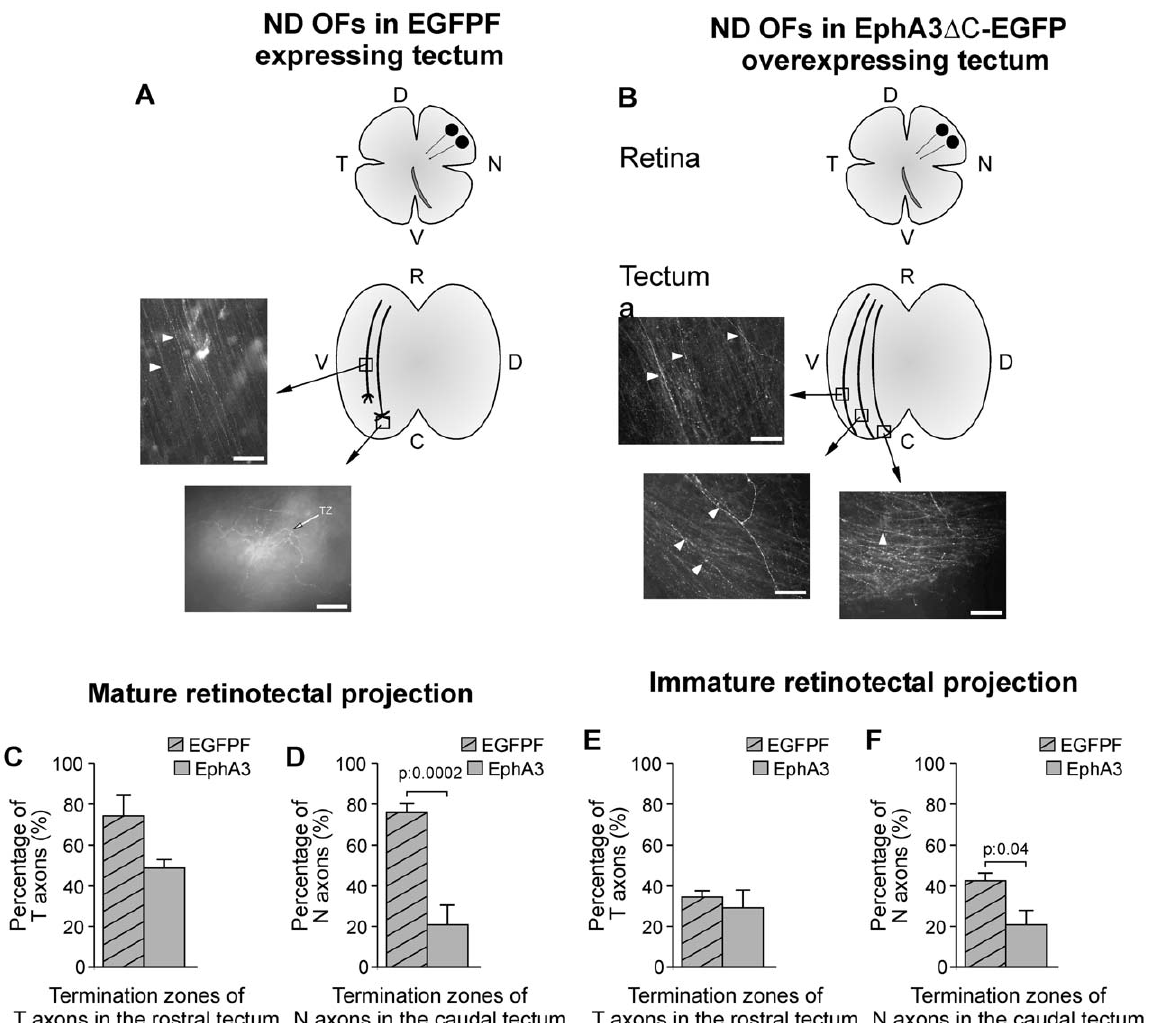
Figure 7. EphA3 ectodomain overexpression alters the topographic map formation. After infection of the optic tectum at E2 with RCAS- BP-B-EGFPF (control) (A) or with RCAS-BP-B-EphA3 D C-EGFPN3 (B) and DiI labeling of the naso-dorsal retina at E16, the retina and the tectum were analyzed in whole mounts at E18 (A, B). Graphs represent retinal whole mounts labeled in naso-dorsal areas (ND) with DiI (black circles) (upper) and tectal whole mounts where the corresponding DiI labeled RGC axons (drawings) are shown in microphotographs. (A) Optic fibers (OFs) pass throughout the intermediate tectum (arrowheads) and form a termination zone (TZ) (arrow) over an area of EGFPF expression in the corresponding target area (caudal tectum) in a control tectum. (B) OFs pass through the target area (caudal tectum) without producing TZs (arrowheads) in a tectum where EphA3 D C-EGFP was overexpressed. N: nasal, T: temporal, V: ventral, D: dorsal, R: rostral, C: caudal. Scale bars =50 m m. (C–F) Graphs show the proportions of temporal (C, E) and nasal (D, F) OFs which form TZs in the rostral and the caudal tectum respectively in EGFPF-expressing tecta versus EphA3 D C-EGFP-overexpressed tecta. (C, D) represent the proportions of TZs observed after the remodeling period -E15 (HH41)-E19 (HH45)- whereas (E, F) represent the proportions of TZs observed during the remodeling period -E11 (HH37)-E14 (HH40)-. (D) Nasal RGC axons (N RGC) present a significantly lower proportion of TZs in the caudal area of EphA3 D C-EGFP-overexpressed tecta between E15 and E19 whereas (C) temporal RGC axons (T RGC) do not present any significant difference in the rostral area of EphA3 D C-EGFP-overexpressed tecta between E15 and E19 (Student t test, n: 6 EphA3 D C-EGFP-overexpressed tecta versus 7 control tecta for nasal RGC; n: 4 EphA3 D C-EGFP-overexpressed tecta versus 10 control tecta for temporal RGCs). (F) Nasal RGCs present a significantly lower proportion of TZs in the caudal area of EphA3 D C-EGFP-overexpressed tecta between E11 and E14 whereas (E) temporal RGCs do not present any significant difference between the rostral areas of the EphA3 D C-EGFP-overexpressed tecta and control tecta (Student t test; n: 6 EphA3 D C-EGFP-overexpressed tecta versus 41 control tecta for nasal RGCs and 5 EphA3 D C-EGFP-overexpressed tecta versus 53 control tecta for temporal RGCs). N: nasal, T: temporal, V: ventral, D: dorsal, R: rostral, C: caudal. Results are shown as mean + / 2 SE.